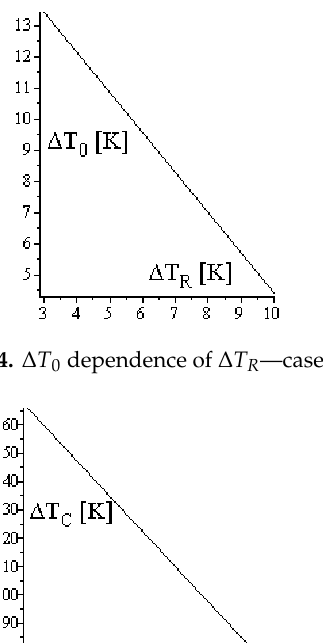
Figure 3. Δ T C dependence of Δ T H —case “a”.